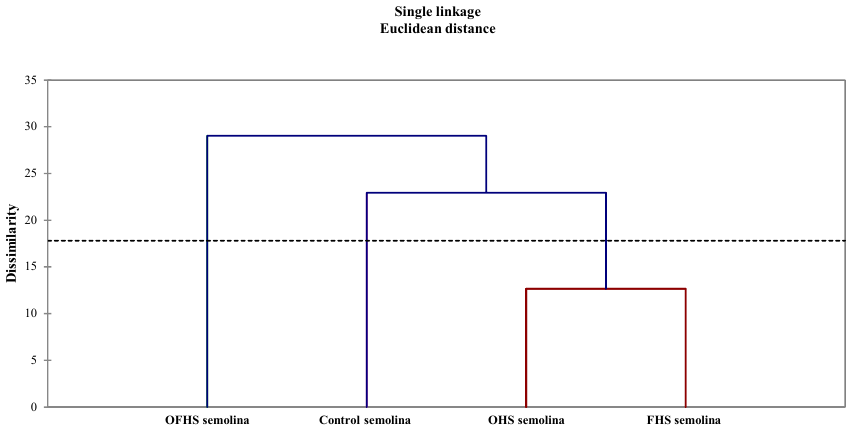
Figure 6. Dendrogram resulting from hierarchical cluster analysis on 26 variables determined on fermented pizza doughs, baked unseasoned pizzas, and final seasoned products. Abbreviations: OHS—obligate heterofermentative lactobacilli; FHS—facultatively heterofermentative lactobacilli;